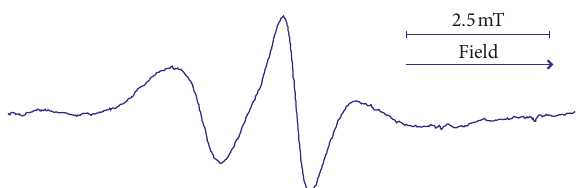
Figure 5: ESR spectrum of spin probe 2 in the erythrocyte sus- pension (control measurement).